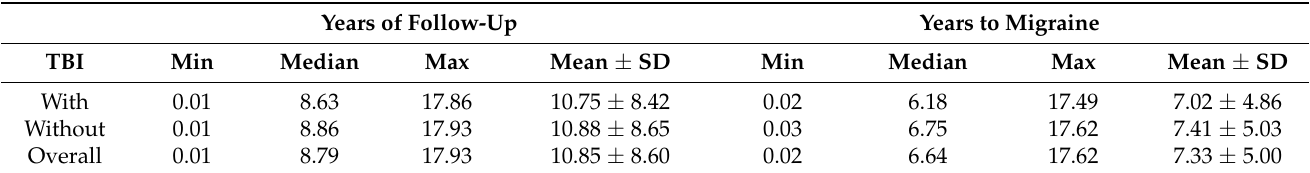
Table 2. Comparison of years of follow-up and years to migraine onset in the TBI and non-TBI cohorts. Years of Follow-Up Years to Migraine Years of Follow-up Years to Migraine TBI Median Max Mean ± SD Min Mean ± SD With 0.01